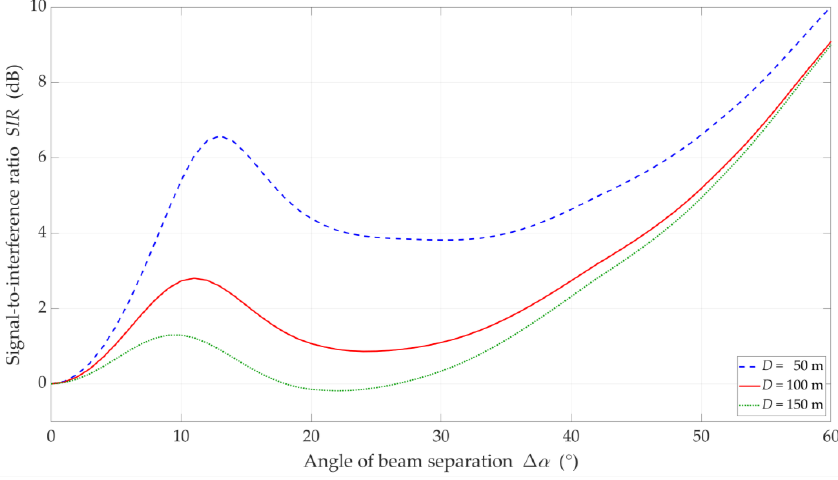
Figure 7. SIR versus separation angle for DL scenario, selected D = {50, 100, 150} m, and NLOS (TDL-B) conditions.